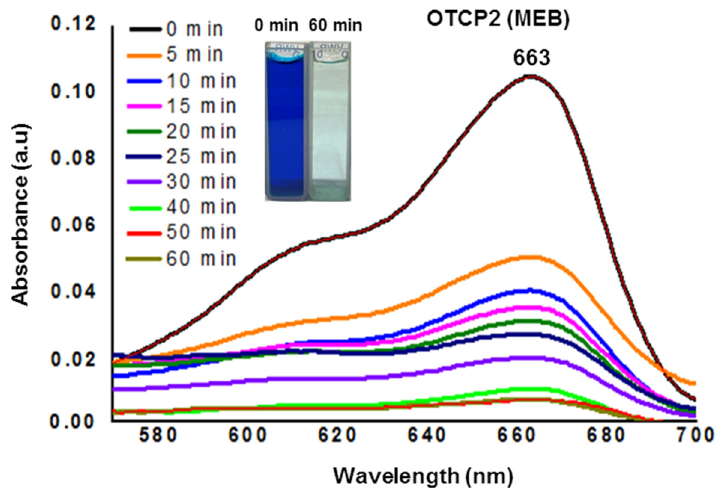
Figure 6. UV–Vis absorption spectrum of MEB aqueous solution (50 mg L − 1 ) in the presence of OTCP2 at various time intervals (inset: samples photos disclosing the color change after dye adsorption).